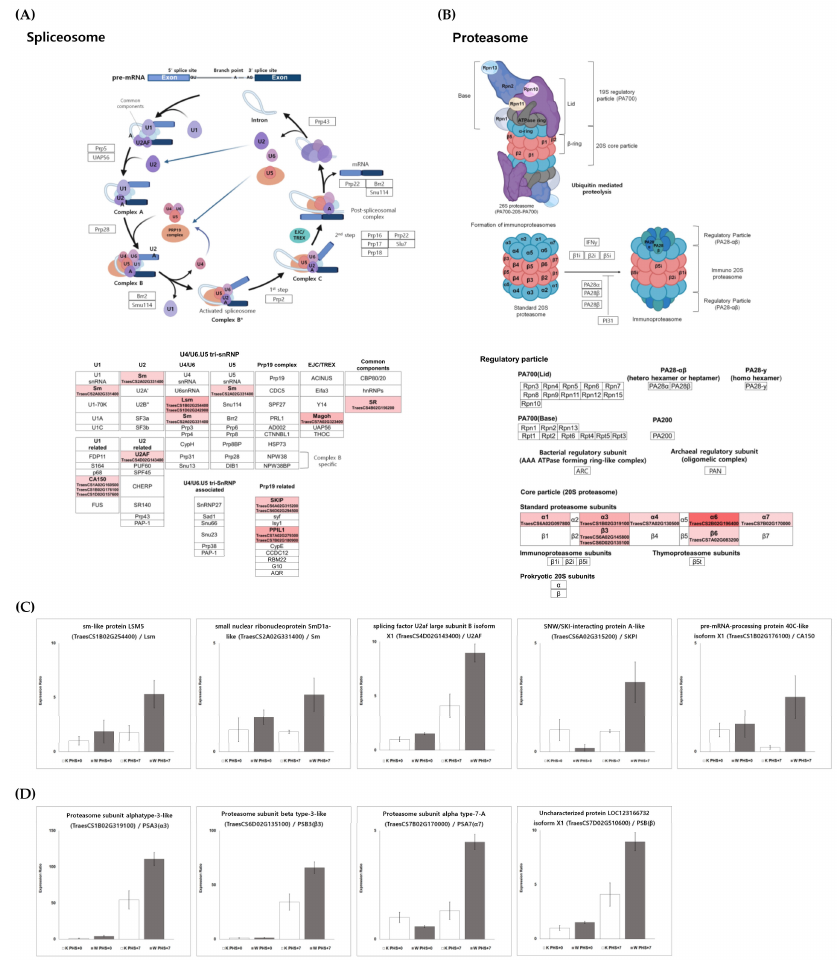
Figure 8. The relative expression profiles and validation of spliceosome and proteasome. The spliceosome pathway was reconstructed based on the KEGG database using Bioreder software. The expression of transcriptome related to the upregulated pathway is represented by red intensity. ( A ) The spliceosome pathway and its related genes represented using KEGG pathway analysis, ( B ) the proteasome pathway and its related genes represented using KEGG pathway analysis, ( C ) validation of genes related to the spliceosome pathway by qRT-PCR, and ( D ) validation of genes related to the proteasome pathway by